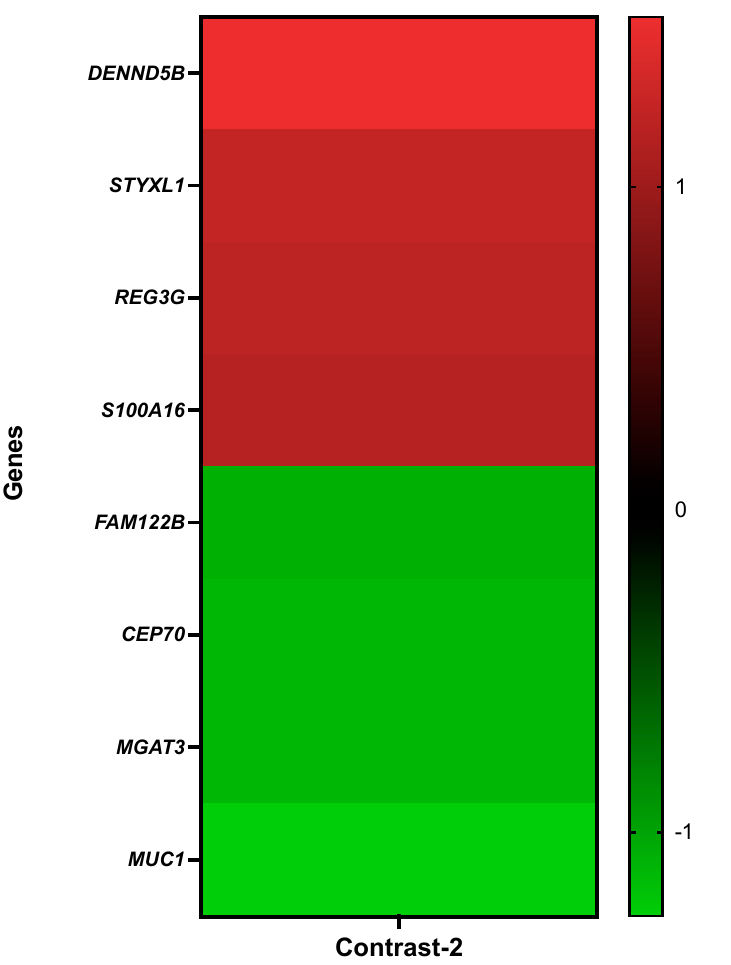
Figure 3. A heat map depicting the color-coded expression levels (log-ratio M values) of the top four upregulated and four downregulated DEGs in the LPS treated IBD enteroids vs. the control IBD enteroids (Contrast-2). The log-ratio M values represent the log(R/G) (log fold change) [44]. The detailed information on genes is presented in Table 5. Table 5. The Gene Ontology (GO) analysis and details about the top four upregulated and four downregulated DEGs in the LPS treated IBD enteroids vs. the control IBD enteroids. The DEGs annotated for the biological process, molecular function, and cellular component categories are shown. The percentages represent the number of genes in each functional